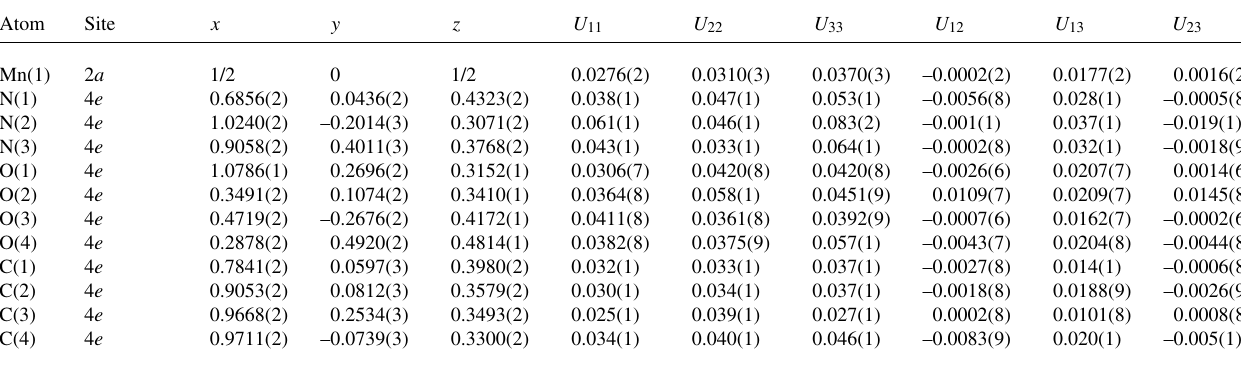
Table 3. Atomic coordinates and displacement parameters (in Å 2 )